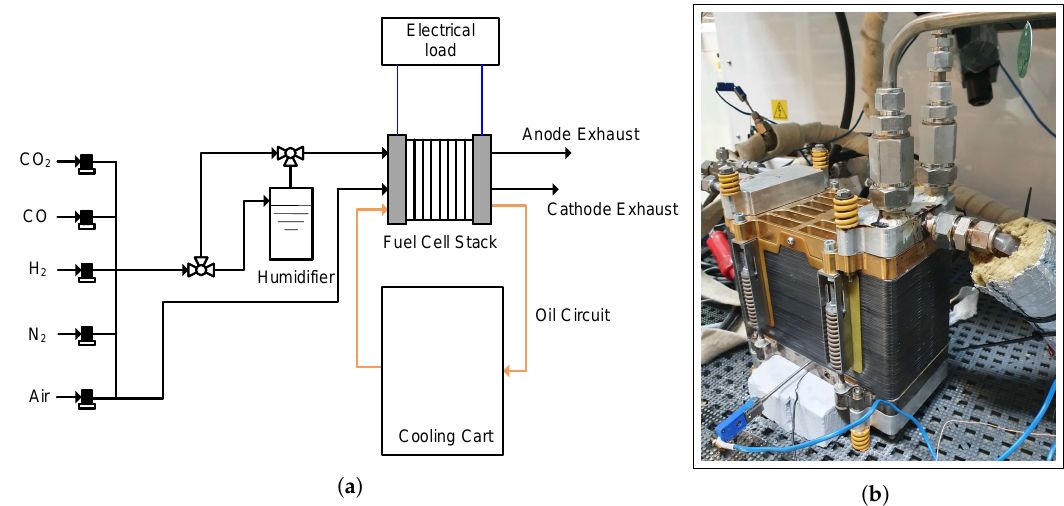
Figure 1. Test setup ( a ) A schematic of the test setup. ( b ) One of the short stacks used in the current